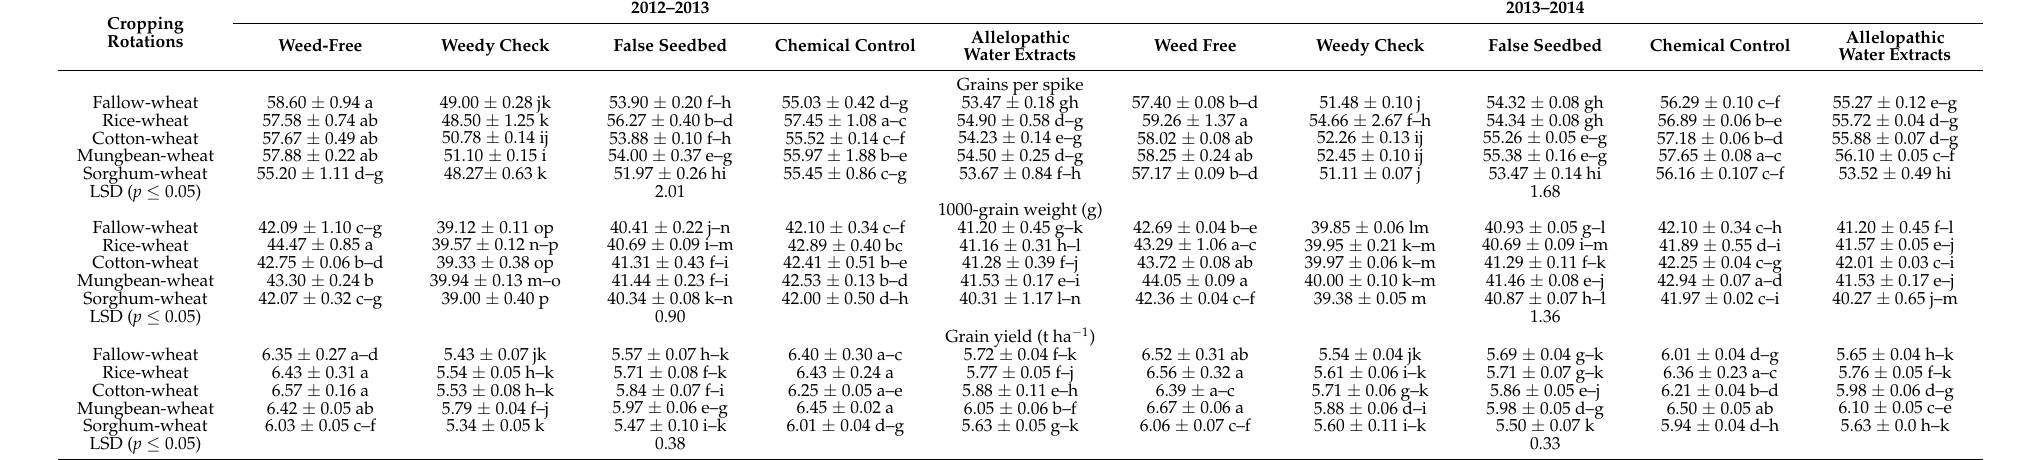
Table 8. Effect of different crop rotations and weed managing strategies on yield parameters and grain yield of